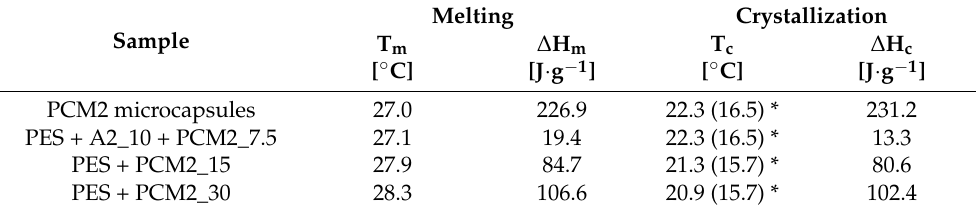
Table 4. Results of DSC analysis of PCM microcapsules and nonwoven inserts.